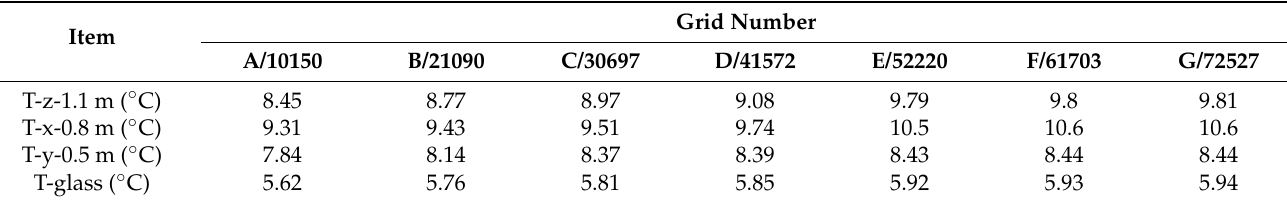
Table 7. Results of the grid independence verification.